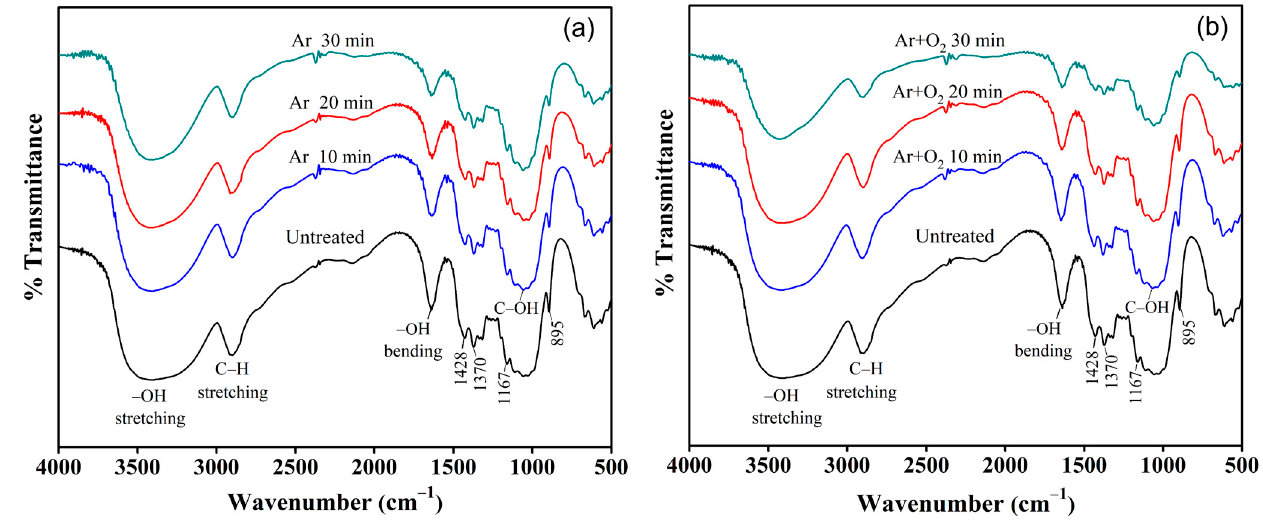
Figure 4. The FTIR spectra of bamboo fiber treated with ( a ) Ar gas and ( b ) Ar + O 2 gas for various treatment times.